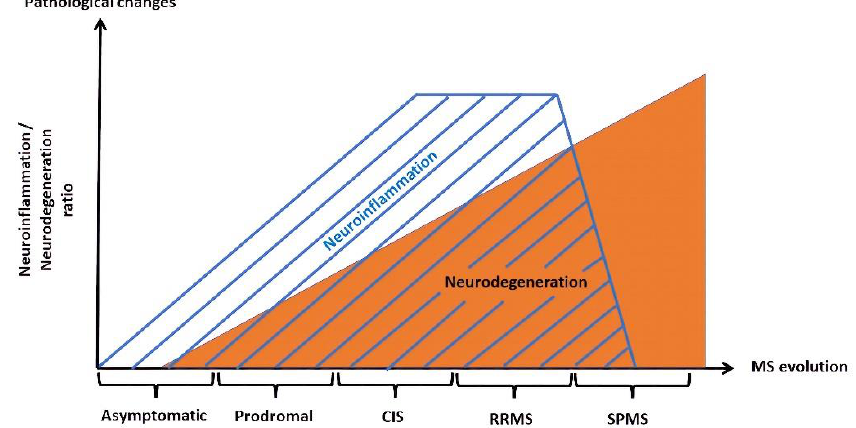
Figure 2. Neuroinflammation and neurodegeneration in multiple sclerosis.